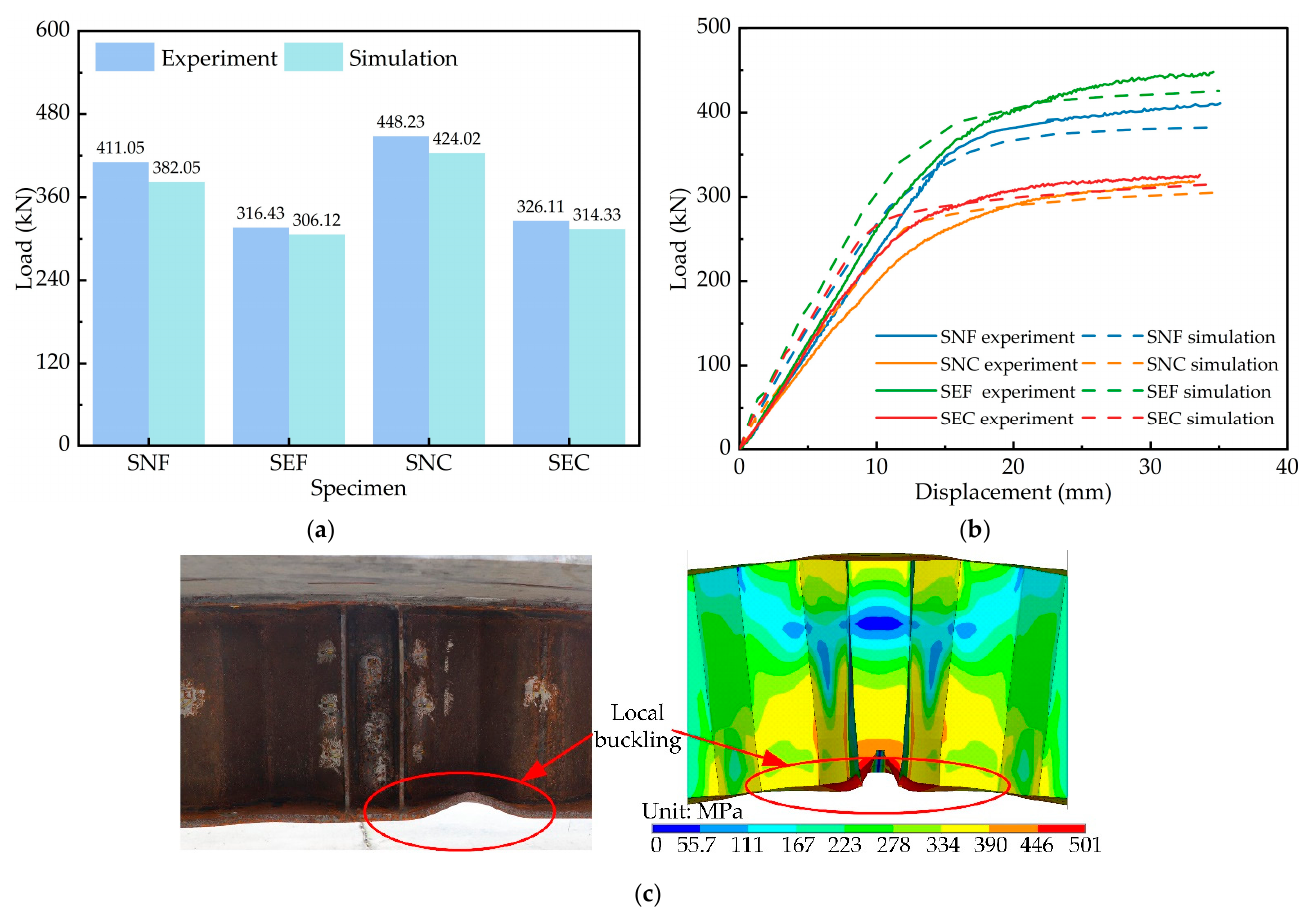
Figure 13. Comparison of specimen and finite element models: ( a ) flexural bearing capacity; ( b ) load–displacement curves; ( c ) failure modes.